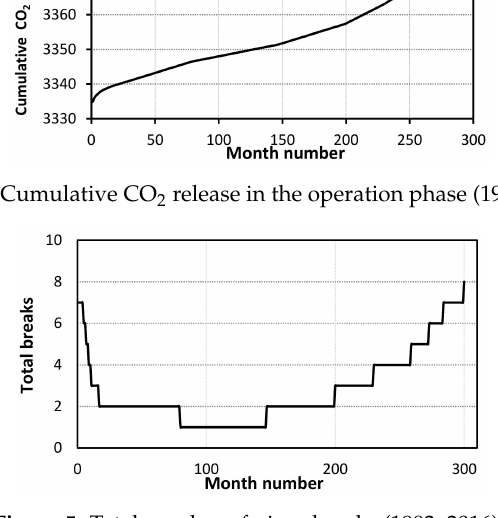
Figure 5. Total number of pipes breaks (1992–2016).